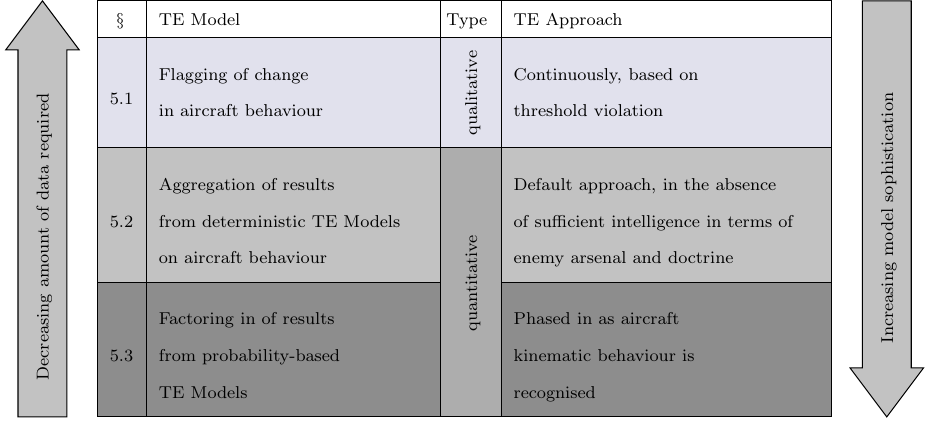
Table 2: Model hierarchy in a TE decision support